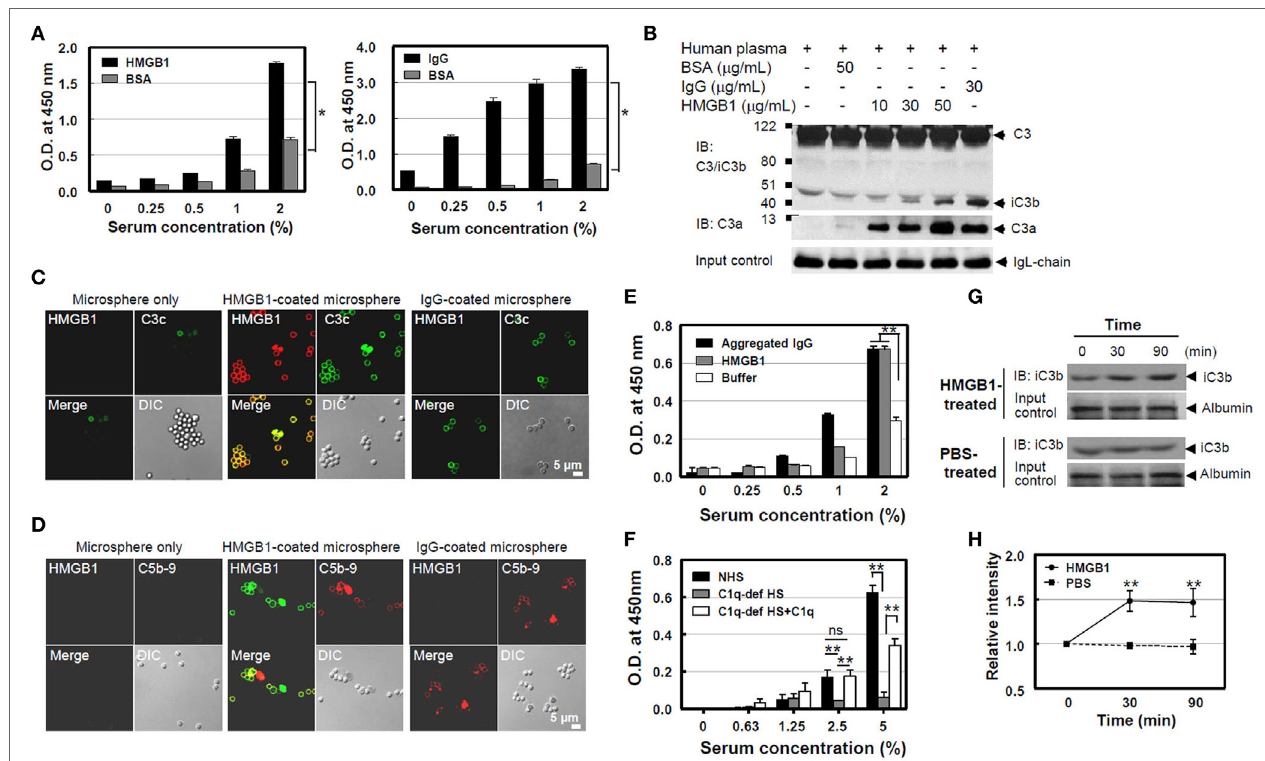
FigUre 2 | High-mobility group box 1 (HMGB1)-mediated cleavage of C4 and C3 and the formation of C5b-9 [membrane attack complex (MAC)]. (a) Measurement of C4b. A microtiter plate was coated with Euk-HMGB1 (10 µg/ml, R&D) and incubated with various concentrations of normal human serum (NHS) to test the deposition of C4b using an enzyme-linked immunosorbent assay (ELISA) (left). Human IgG (10 µg/ml) was used as the positive control (right). (B) To determine C3a and iC3b, the cleavage product of C3b. Fifty microliters of NHS (diluted 1:5) was incubated with increasing amounts of HMGB1 for 30 min at 37°C, then performed Western blot analysis using anti-C3/iC3b or anti-C3a antibodies. Aggregated human IgG and Ig-free BSA served as the positive and negative controls, respectively. Ig light chain (IgL) was used as input control. (c,D) Measurements of complement activation products of C3c, the cleaved form of C3b, and C5b-9. Biotinylated HMGB1s were incubated with streptavidin-coated microspheres in 10% NHS, which was pre-absorbed with non-coated microspheres, for 30 min at 37°C. Immunofluorescence staining was performed with anti-HMGB1 and fluorescein isothiocyanate-conjugated anti-C3c antibody (Ab). For C5b-9 deposition, immunofluorescence staining was performed with anti-HMGB1 (green) and anti-C5b-9 Ab (red). Biotinylated human IgG was used as the positive control. (e) A microtiter plate was coated with HMGB1 (10 µg/ml) and incubated with various concentrations of NHS to test the deposition of C5b-9 using an ELISA. Aggregated human IgG was used as the positive control. (F) C1q-dependent MAC formation. A microtiter plate was coated with HMGB1 (10 µg/ml) and incubated with various concentrations of NHS or C1q-depleted human serum (C1q-dep HS) to test the deposition of MAC formation using an ELISA for C5b-9. To restore the effect of C1q, 20 µg/ml of C1q was added to C1q-depleted human serum. ns: not significant. (g,h) Measurement of complement activation after HMGB1 injection in mice. C57BL/6 mice were intravenously injected with 100 µg of HMGB1 or PBS to observe if HMGB1 can activate complement in vivo ( N = 3 per group). Blood samples were collected at 0, 30, and 90 min after the injection. iC3b (arrow) was detected using Western blot analysis of serum sample from one representative mouse. Relative band intensity of iC3b was analyzed. All data shown here are representative of at least three independent experiments with similar results. Error bars are mean ± SD. * P < 0.05, ** P < 0.01 by Student’s paired t -test (a) or two-way ANOVA (e,F,h)